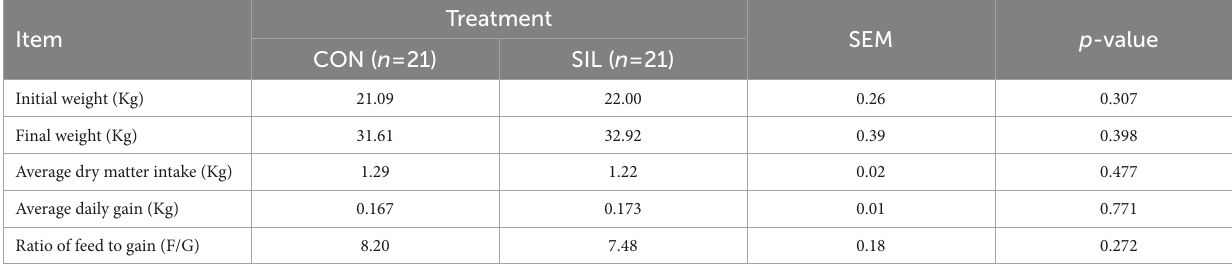
TABLE 2 Effect of silybum marianum meal as a replacement for soybean meal on feed intake and growth performance of